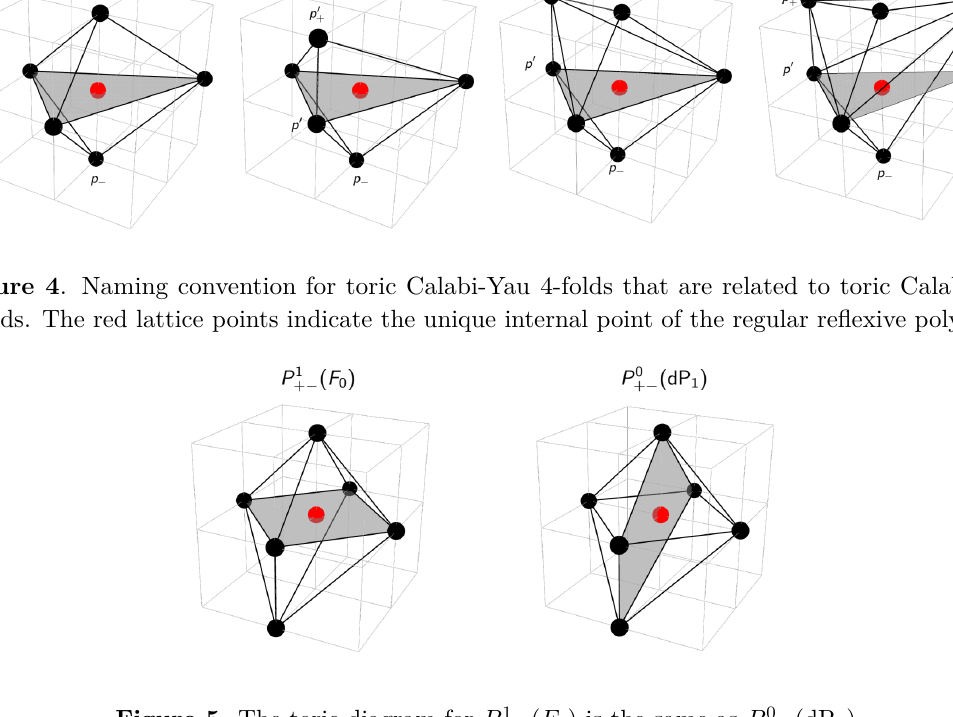
Figure 5 . The toric diagram for P 1